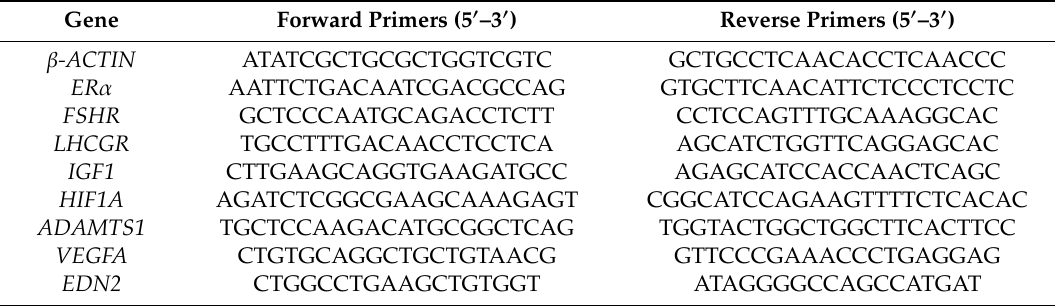
Table 1. Bovine specific primers used for real-time